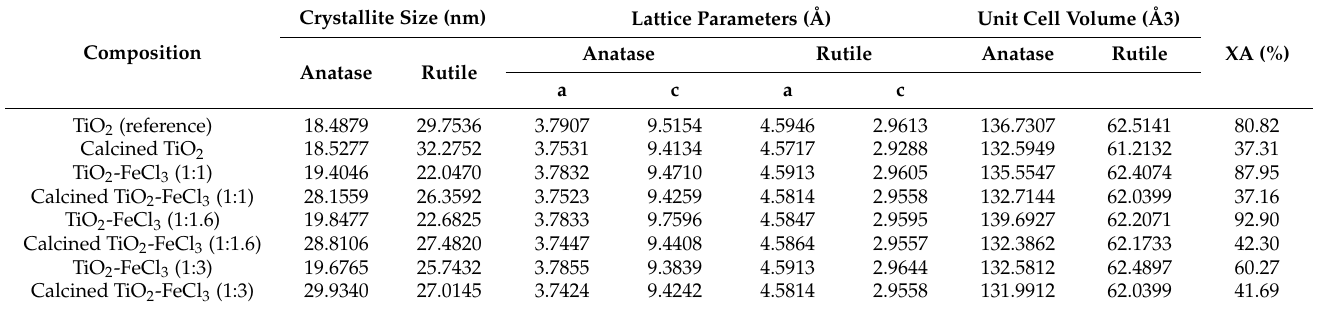
Table 1. Influence of doped material before and after calcination as to the on average crystallite size, lattice parameters, unit cell volume, and anatase phase fraction for doped TiO 2 nanoparticles. Crystallite Size Composition